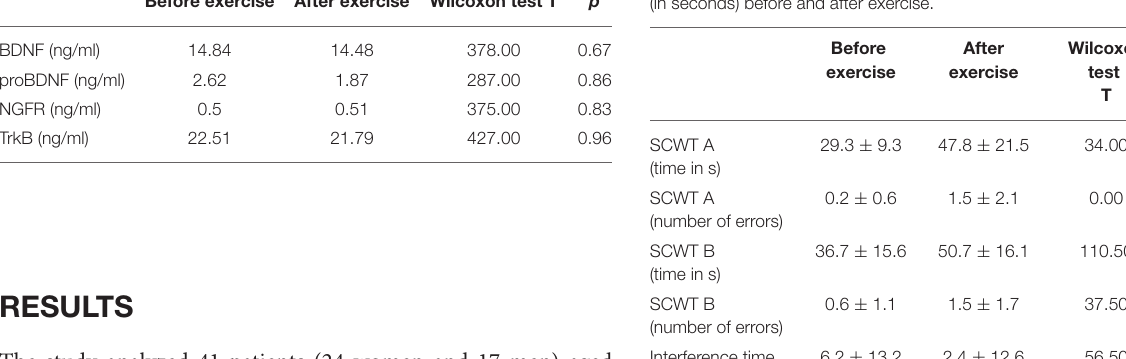
TABLE 2 | Protein concentrations (BDNF, proBDNF, BDNF, NGF, and TrkB) did not change significantly due to exercise. Before exercise After exercise Wilcoxon test T